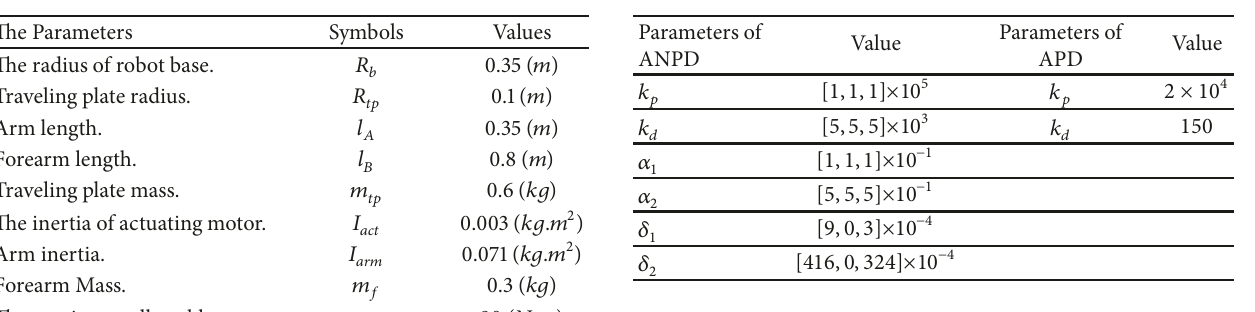
Table 1: Numerical values of system parameters [10]. Table 2: Settings of controller